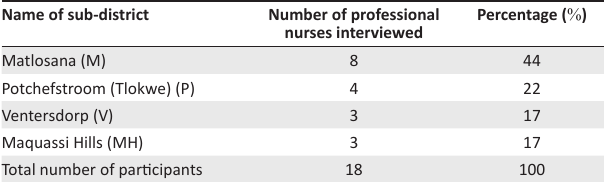
TABLE 1: Participation distribution per